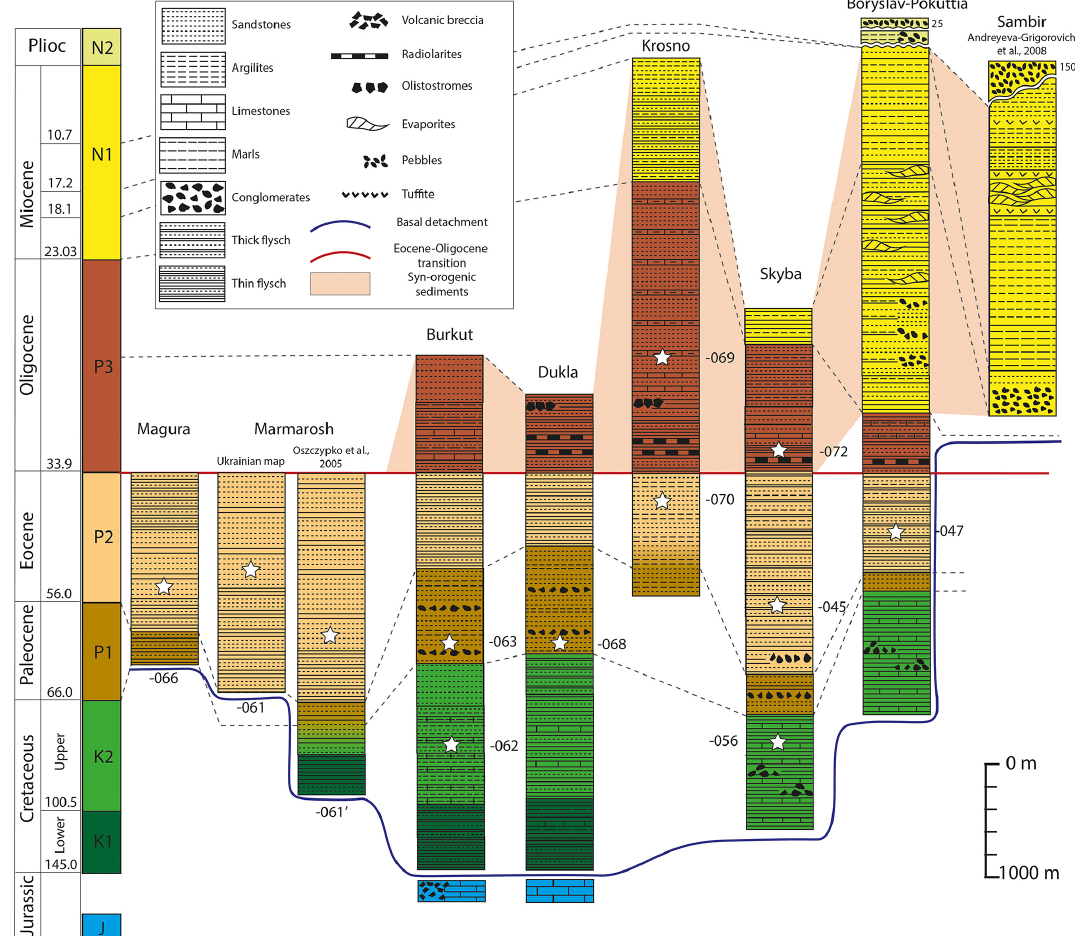
Figure 2. Regional stratigraphy of the Ukrainian Carpathian nappes, mainly from Ukrainian geological maps (Docin, 1963; Vashchenko et al., 2006; Gerasimov et al., 2005; Matskiv et al., 2008, 2009). Stars mark the sample locations in the nappe stratigraphy; samples are identified by their suffix. The dark blue line marks the décollement horizon of the nappes. Jurassic rocks are integrated in the Burkut and Dukla nappes. Syn-orogenic sediments are indicated in the beige zone, and older deposits are regarded as pre-orogenic. Any syn-orogenic sediments on the Magura and Marmarosh nappes have been eroded. Two interpretations of the stratigraphy are indicated for the Marmarosh nappe: one from the Ukrainian geological map and the other from Oszczypko et al. (2005). The Sambir nappe stratigraphy is after Andreyeva-Grigorovich et al. (2008), adapted to the revised stratigraphic limits of Paratethys stages (Krijgsman and Piller, 2012). The stratigraphic columns depicted here are the closest ones available to the sampling site of each sample. Lateral variations in thickness or nature of deposition within individual nappes are not represented by these